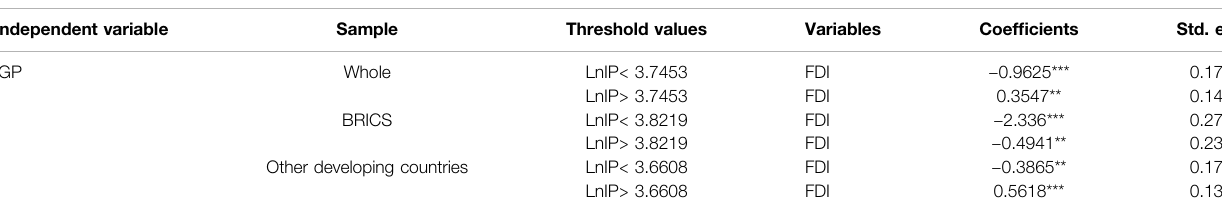
TABLE 6 | Panel threshold